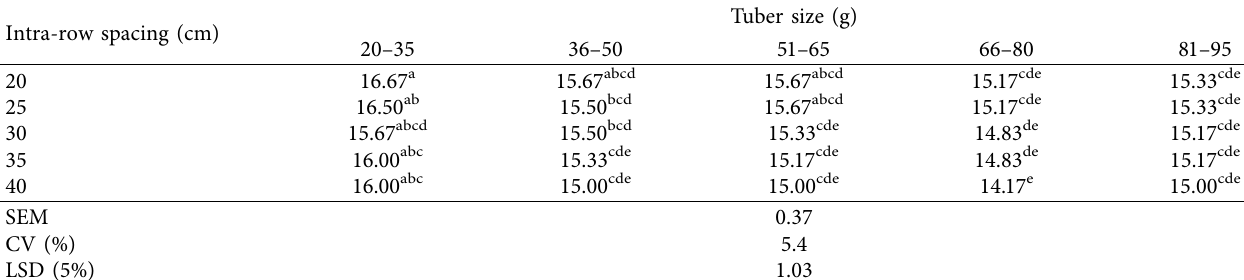
Table 3: Interaction effect of intra-row spacing and tuber size on days to 50% emergence of potato in 2013/2014 at Nono Benja. Intra-row spacing (cm)